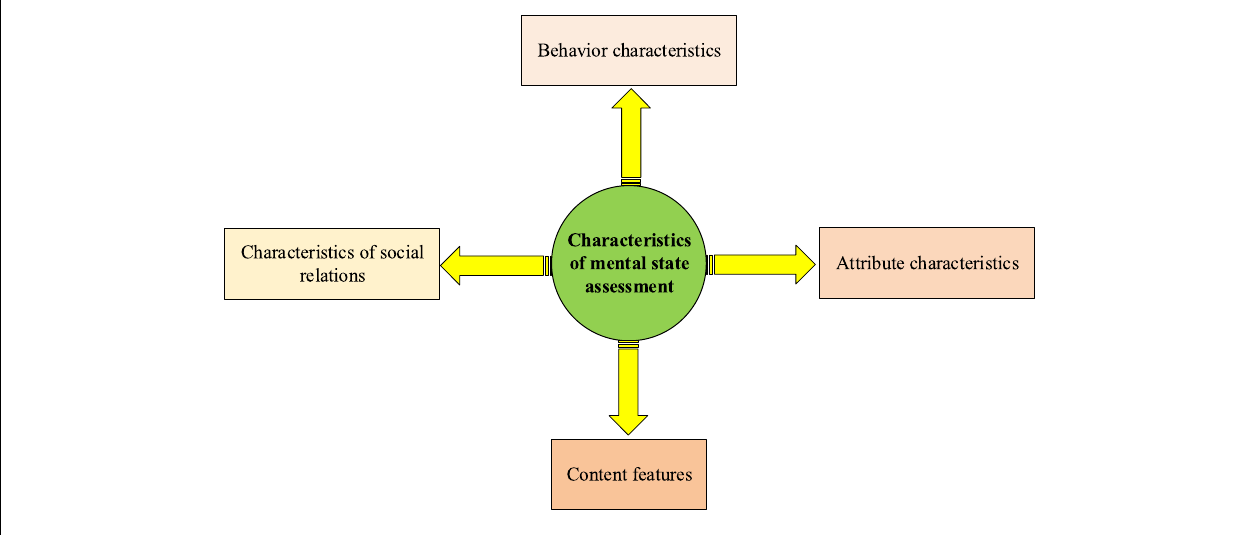
FIGURE 2 | Characteristic system of mental state evaluation.